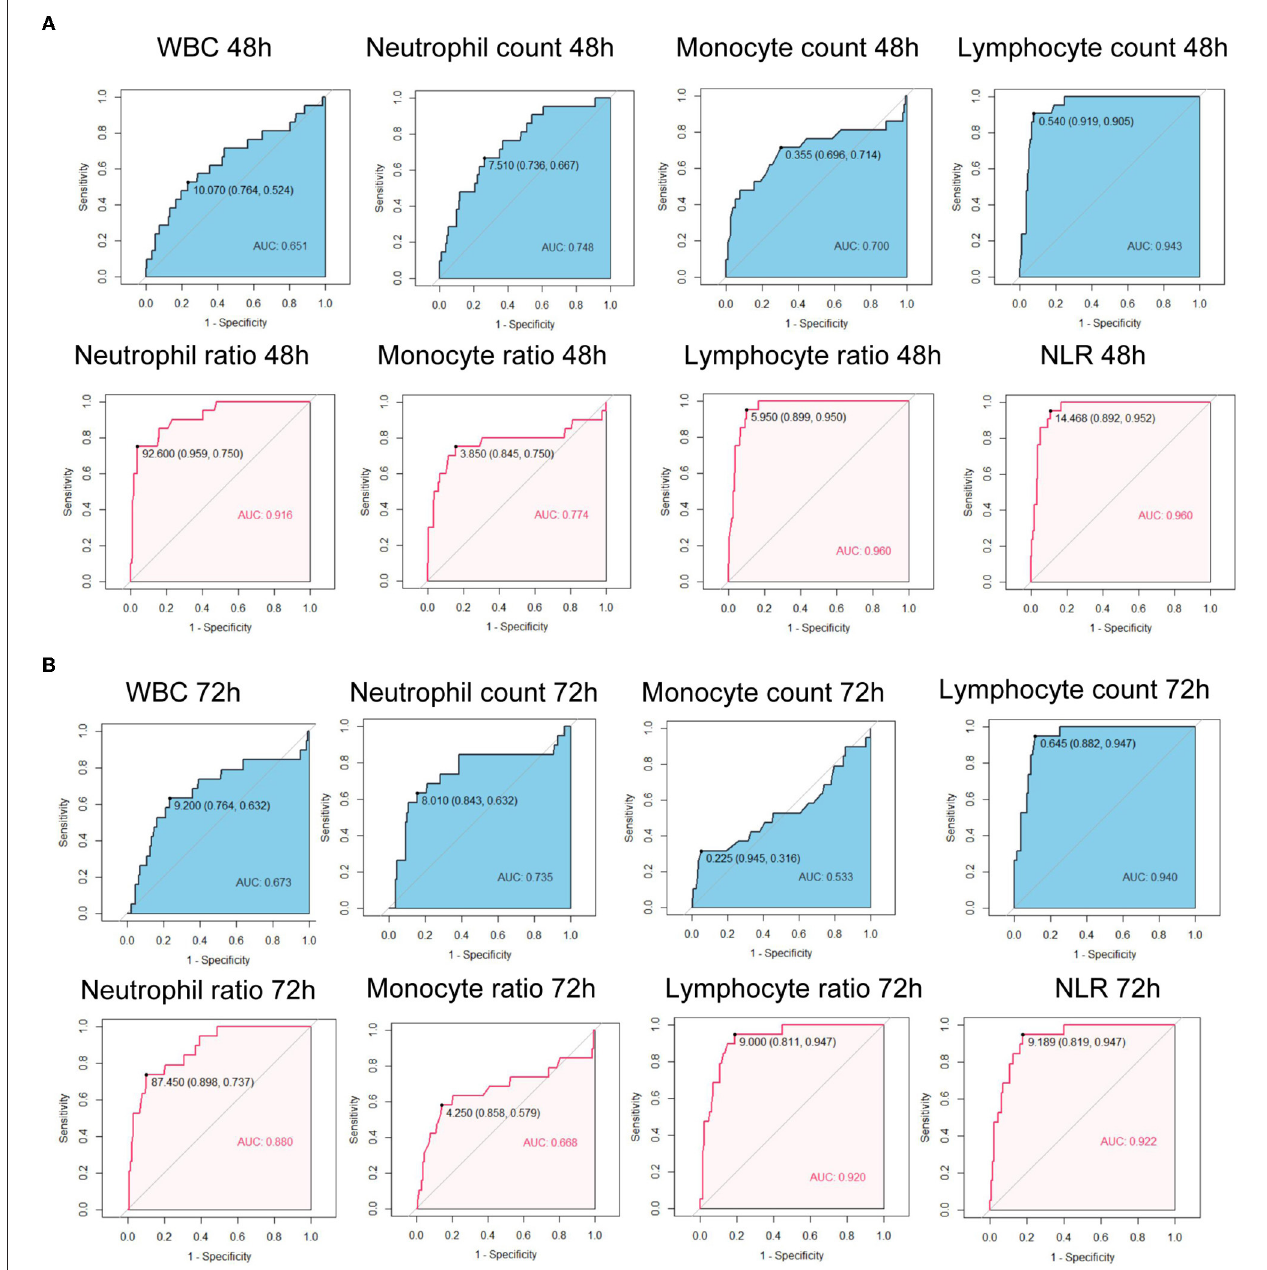
FIGURE 2 | Receiver operating characteristic curves of immune cell counts and ratios at 48h after admission (A) and at 72h after admission (B) for 90-day fatality in patients with EHS. WBC, white blood cell; NLR, neutrophil to lymphocyte ratio; AUC, area under curve.